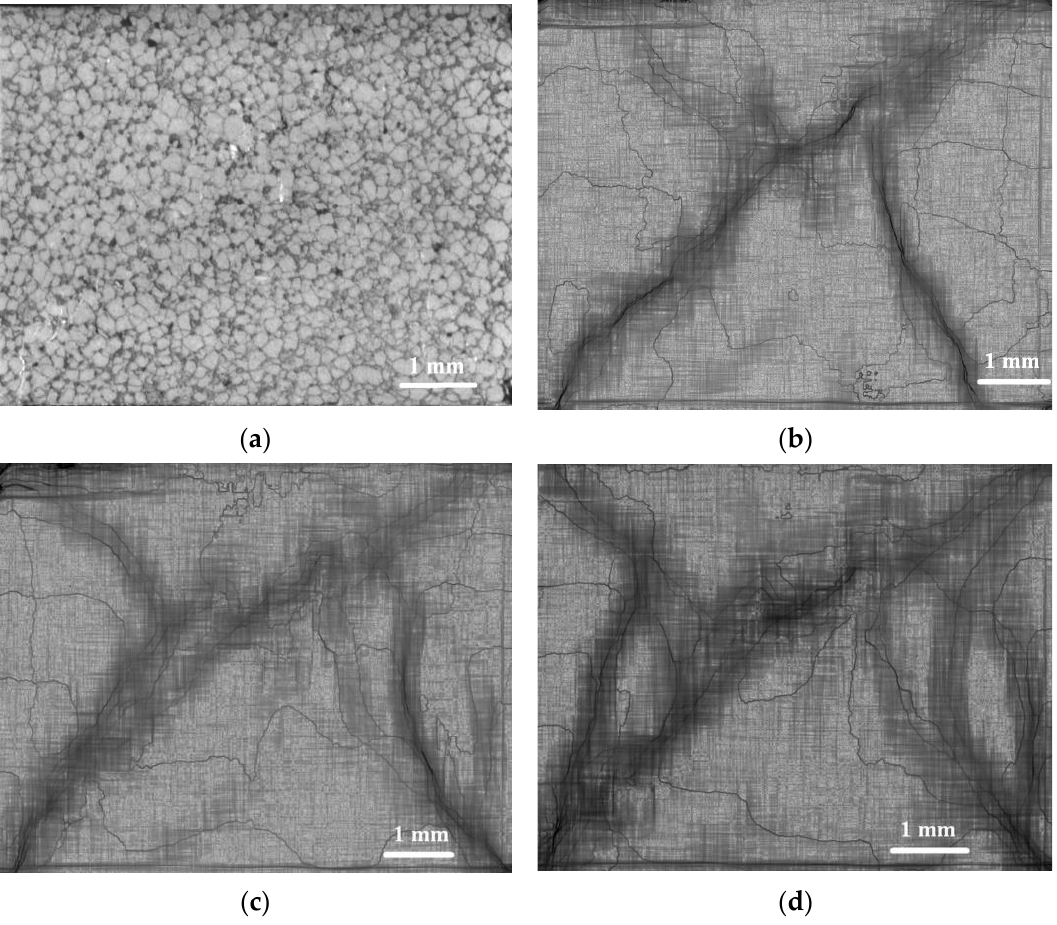
Figure 8. Optical macrograph ( a ) and deformation maps ( b – d ) of Sample #1 at the deformation Stage II at strain are as follows: ε = 0.062 ( a ), ε = 0.037, ∆ ε = 0.010 ( b ), ε = 0.050, ∆ ε = 0.010 ( c ), and ε = 0.062, ∆ ε = 0.010 ( d ).